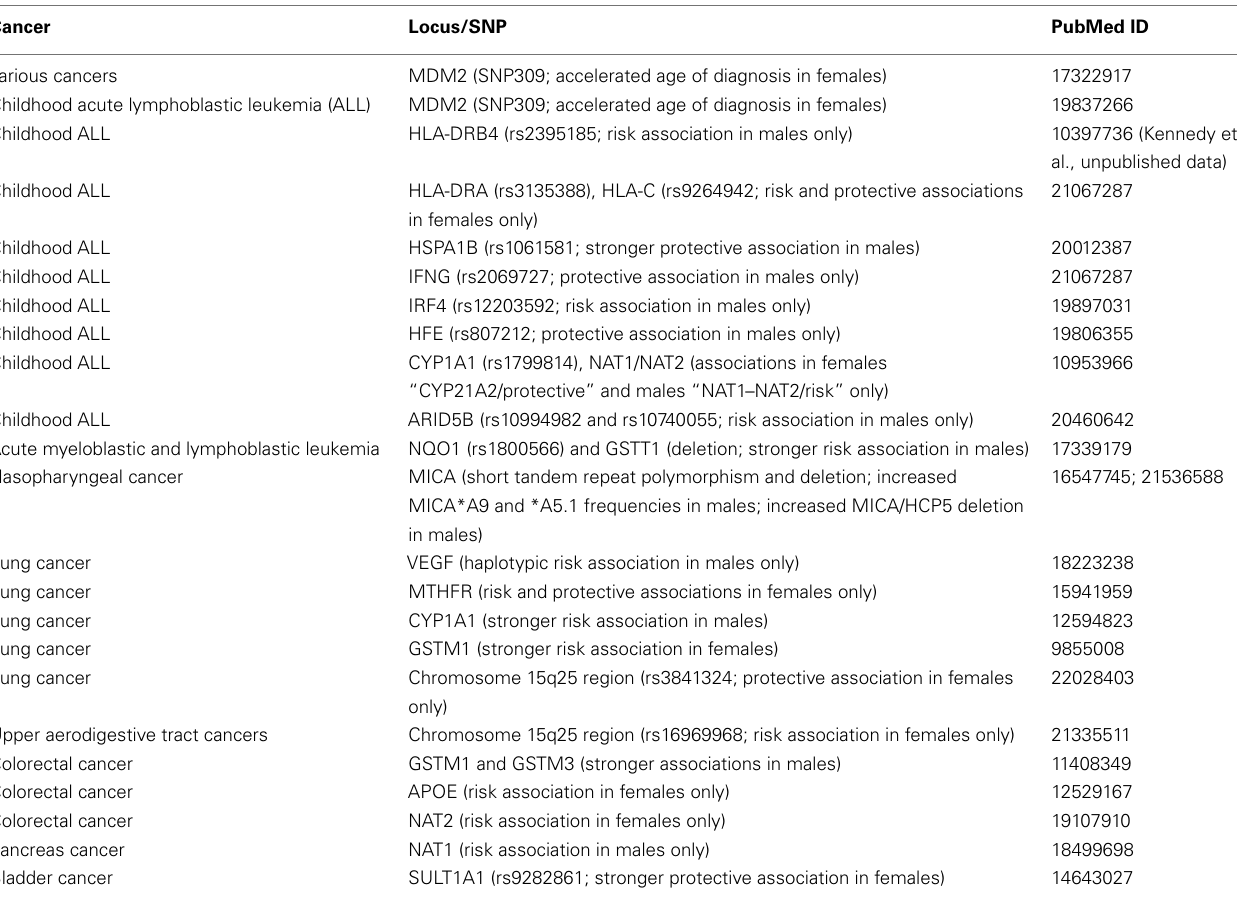
Table 2 | Examples of genetic associations with cancer susceptibility exclusive to males or